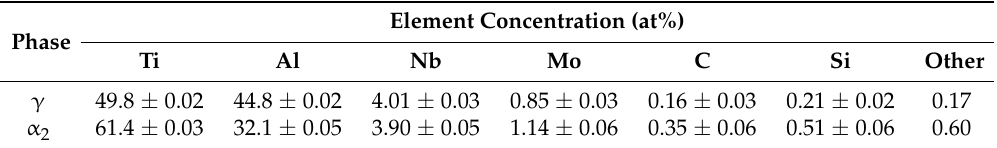
Table 2. Phase composition of the lamellar structure depicted in Figure 10 as studied in reference [52]. The errors given correspond to the standard errors. Nb shows a weak preference for the γ phase, whereas Mo evidences a weak preference for the α 2 phase. C and Si prefer to locate in the α 2 phase.